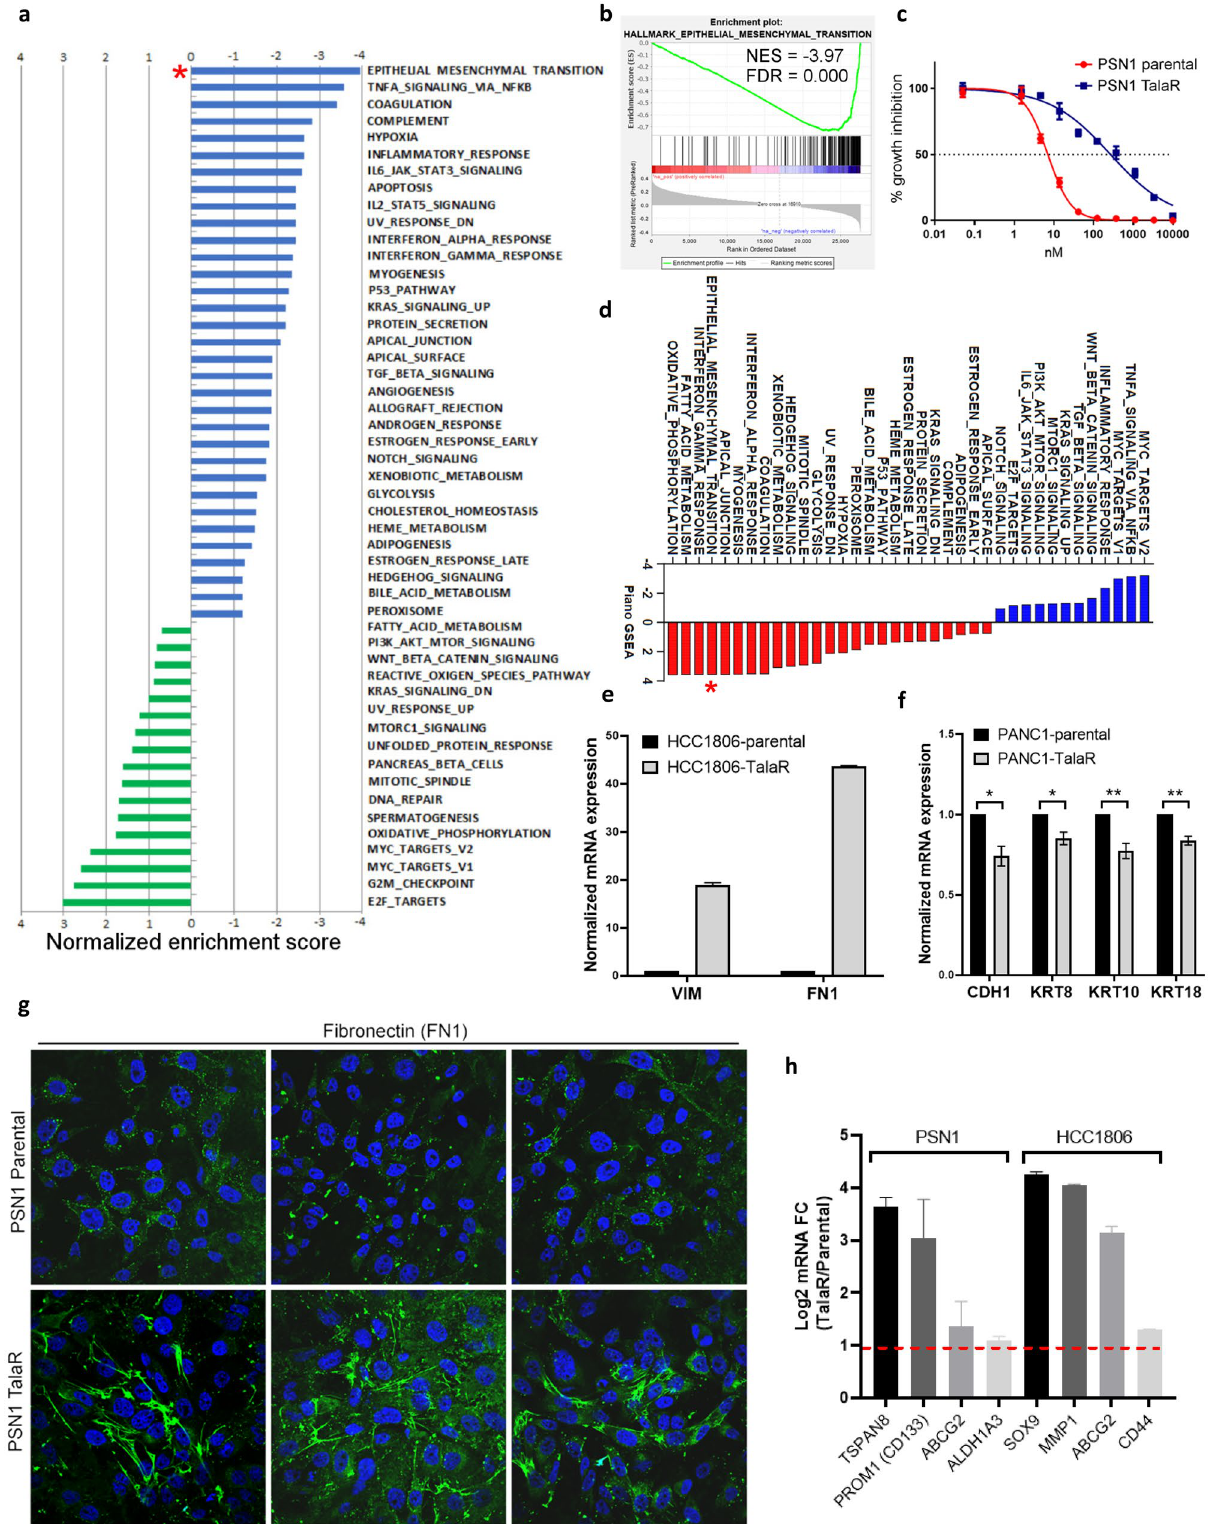
Figure 1. EMT signature correlates with intrinsic and acquired resistance to Talazoparib. ( a ) Pathway enrichment analysis showing pathway association with Talazoparib BOE. Negative normalized enrichment score indicates resistance, positive score indicates sensitivity. ( b ) Gene set enrichment analysis indicates correlation between EMT hallmark with intrinsic resistance to Talazoparib from BOE. ( c ) Talazoparib IC 50 curves of parental PSN1 cells and cells with acquired resistance to Talazoparib. ( d ) Pathway enrichment analysis on total proteome of PSN1 parental and TalaR cells (n = 15). ( e , f ) qPCR showing mRNA level changes of mesenchymal and epithelial markers TalaR cells. ( g ) Immunostaining of fibronectin in PSN1 parental and TalaR cells. Three different fields in each group are shown. ( h ) qPCR showing upregulated cancer stem cell markers in PSN1 and HCC1806 TalaR cells vs parental cells. Dashed red line indicates twofold